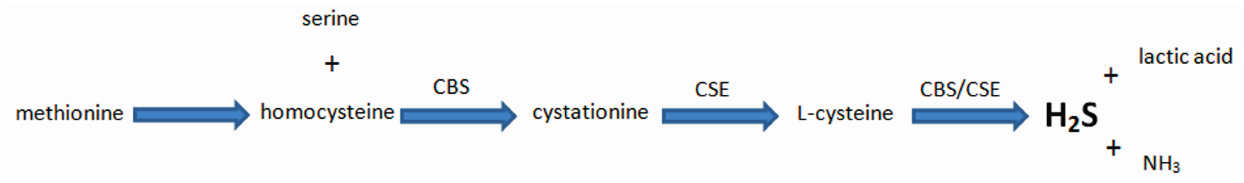
Figure 2. Simplified hydrogen sulfide synthesis